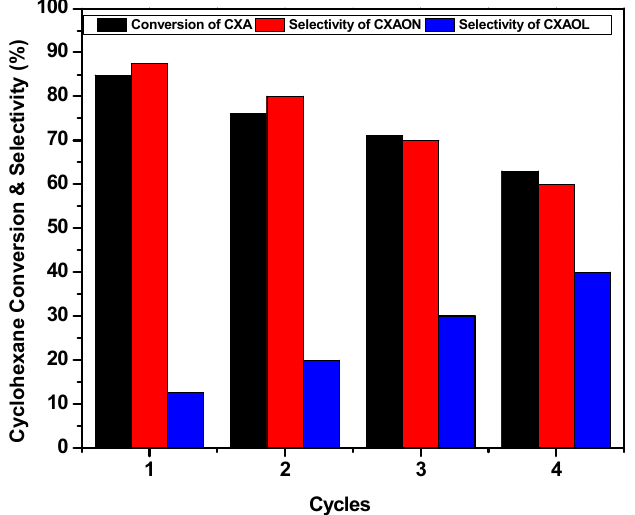
Figure 11. Reusability of NiO powder as a catalyst in the oxidation of cyclohexane with m -CPBA. Conditions: catalyst: 50 mg, m -CPBA (1.5 eq), time: 24 h, T = 70 ◦ C, 1